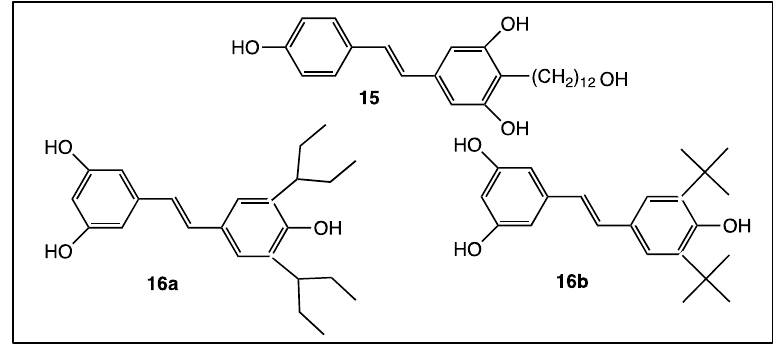
Figure 8 . Structure of Resveratrol Fatty Alcohol (RFAs) ( 15 ) and compounds 16a and 16b.